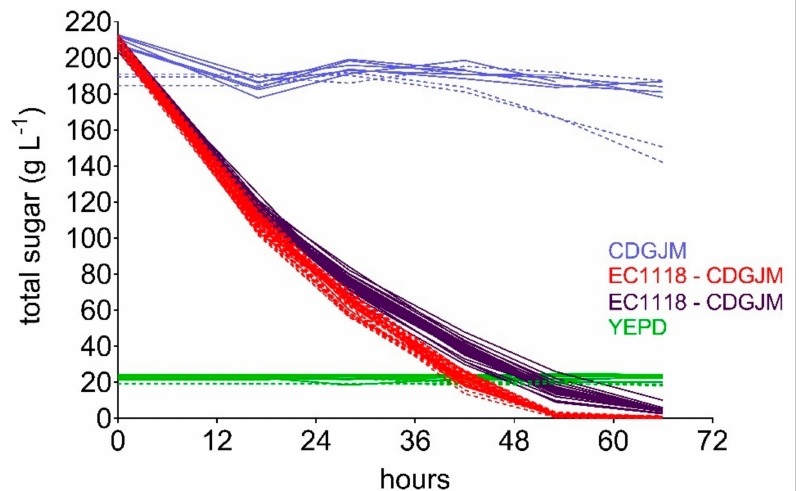
Figure 5. Comparison between shake flask and Generation #1 platform based fermentations using a single yeast (EC1118). The strain was fermented as technical replicates in ‘Teebot’ bottles ( n = 30; purple solid line) and flasks ( n = 40; red dashed line). Sterility controls (no yeast) were included as technical replicates for YEPD (3 flasks, green dashed line and 12 Teebot bottles, green solid line) and CDGJM (3 flasks, blue dashed line and 6 ‘Teebot’ bottles, blue solid